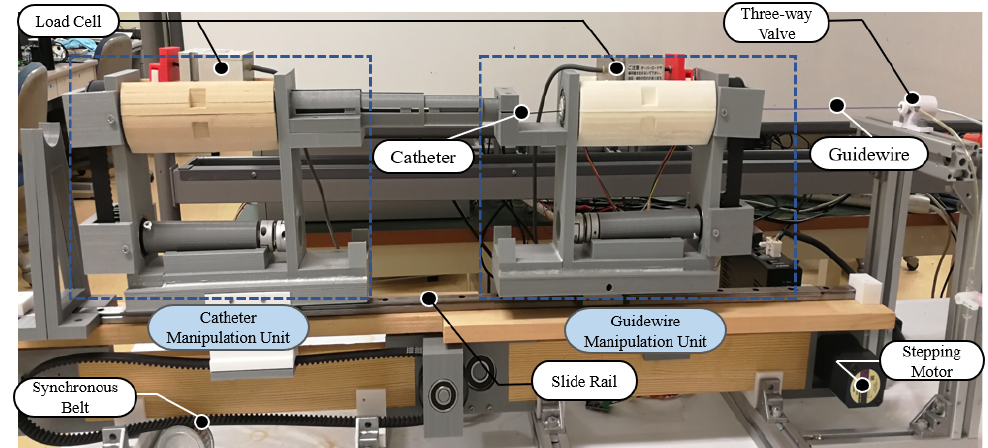
Figure 3. The slave manipulator-robot. Detailed components of slave side: CMU (catheter manipulation unit), GMU (guidewire manipulation unit), Surgical instruments (catheter and guidewire). For more details, see [3].